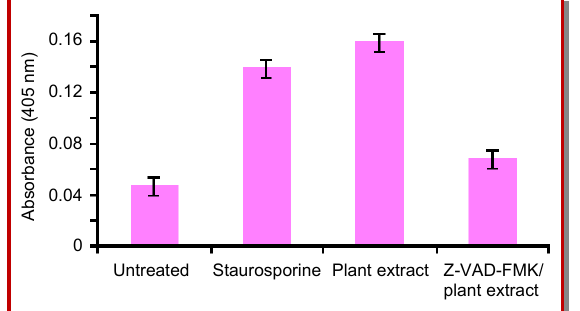
Figure 3: Measurement of caspase-3 activity in CHO cells treat- ed with T. violacea crude aqueous extract CHO cells were treat- ed with 1 µM staurosporine (positive control), 0.5 mg/mL of the plant extract and the plant extract plus Z-VAD-FMK inhib-